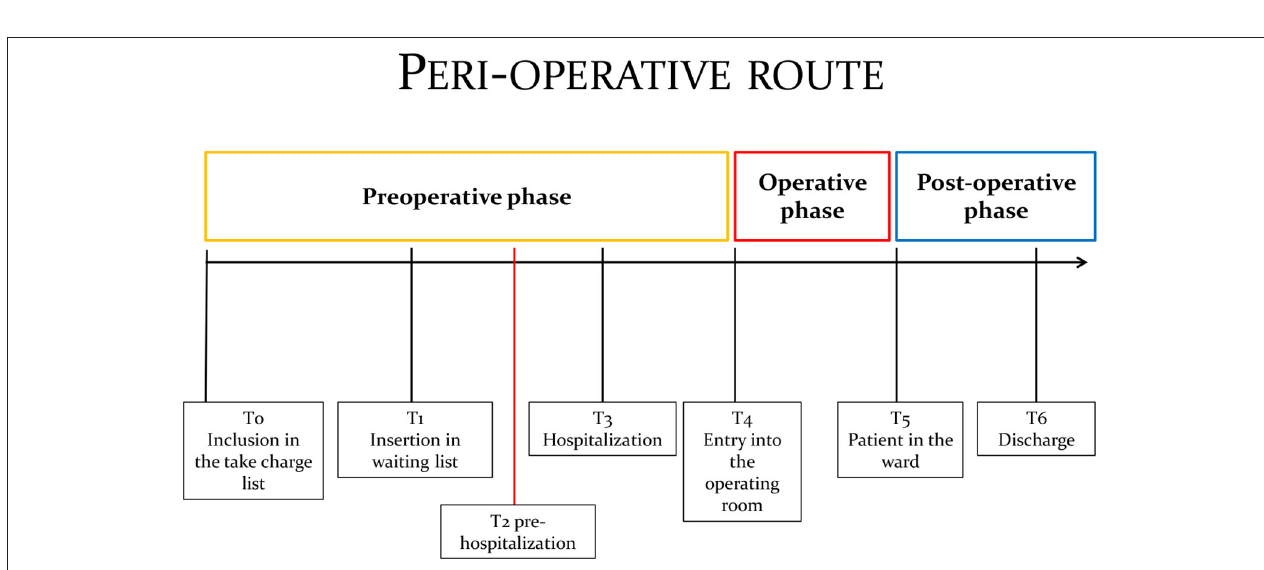
FIGURE 2 | The Perioperative